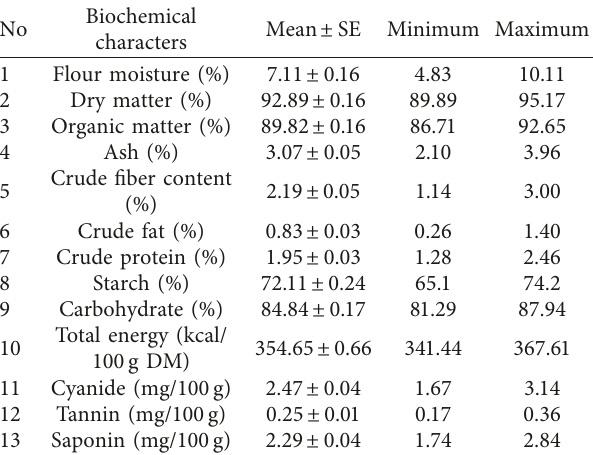
Table 3: Mean, maximum, and minimum values of biochemical contents measured from 64 accessions of